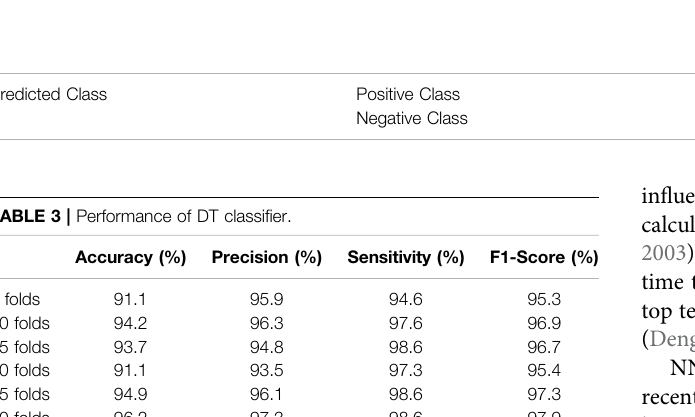
TABLE 2 | Confusion matrix for the classi fi er method.